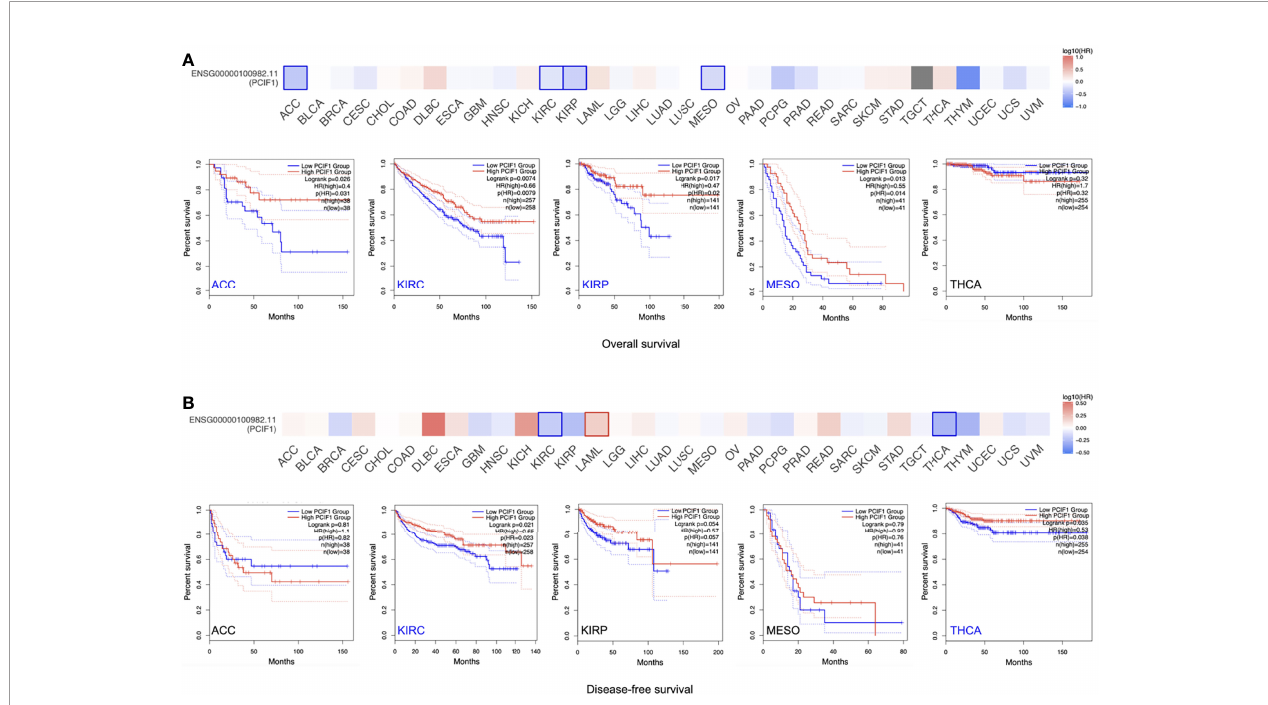
FIGURE 2 | Correlation of PCIF1 gene expression and overall survival, disease-free survival of TCGA tumors. (A) Correlation of PCIF1 gene expression in ACC ( p < 0.05), KIRC ( p < 0.05), KIRP ( p < 0.05), MESO ( p < 0.05), and THCA ( p > 0.05) and overall survival of corresponding tumors. (B) Correlation of PCIF1 gene expression in ACC ( p > 0.05), KIRC ( p < 0.05), KIRP ( p > 0.05), MESO ( p > 0.05), and THCA ( p > 0.05) and disease-free survival of corresponding